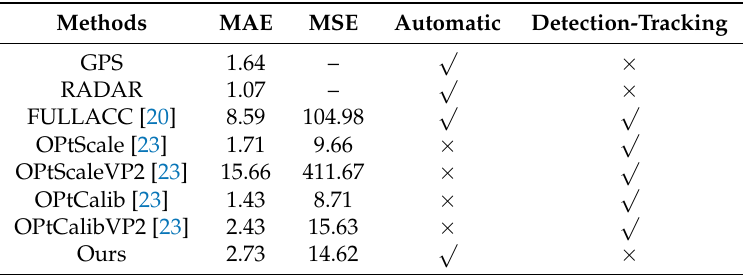
Table 7. Comparison of different Methods on the same